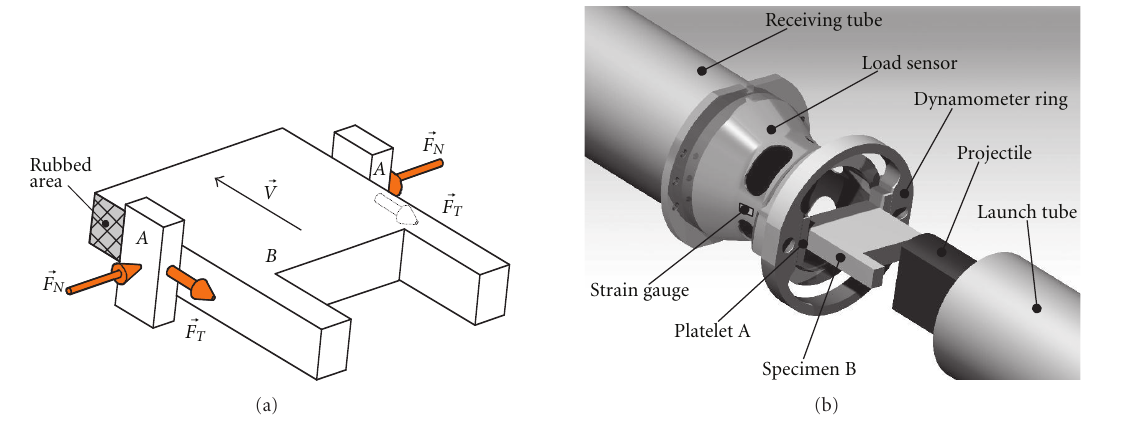
Figure 1: Details of the dynamical tribometer.